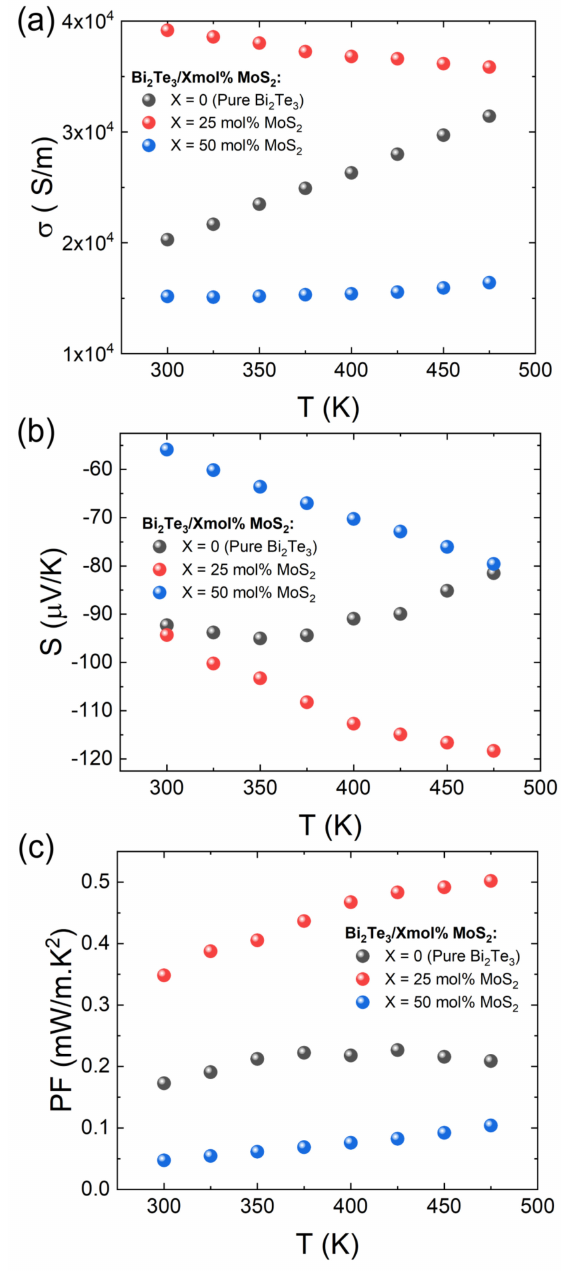
Figure 3. Temperature dependence of ( a ) electrical conductivity σ , ( b ) Seebeck coefficient S , and ( c ) power factor PF of the Bi 2 Te 3 /X mol%MoS 2 (X = 0, 25, 50)